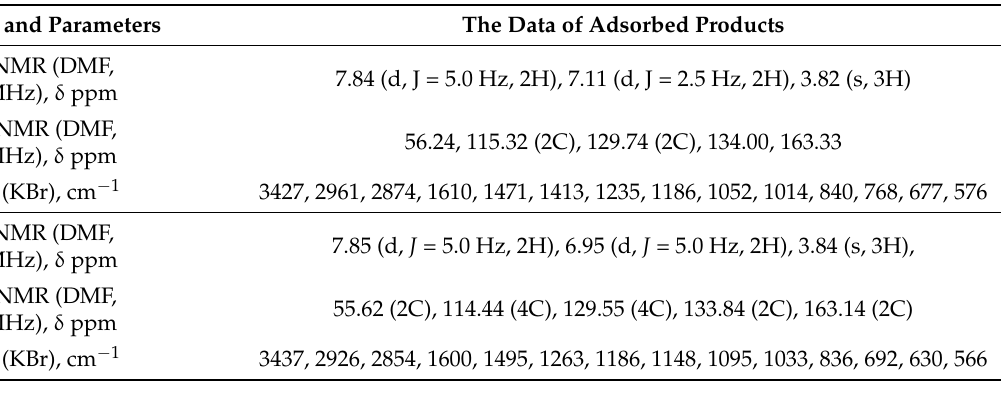
Table 2. Summary of the experimental conditions. Exp. No.